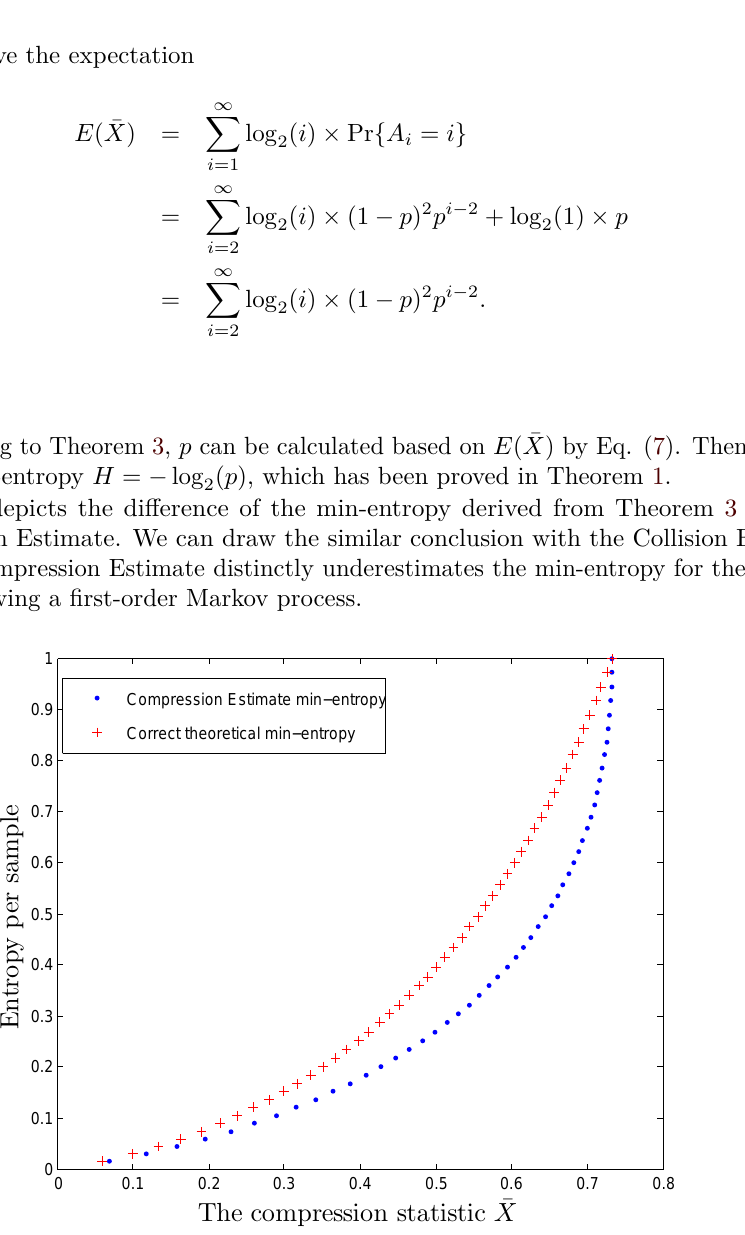
Figure 2: The comparison of min-entropy derived from Theorem 3 and the Compression